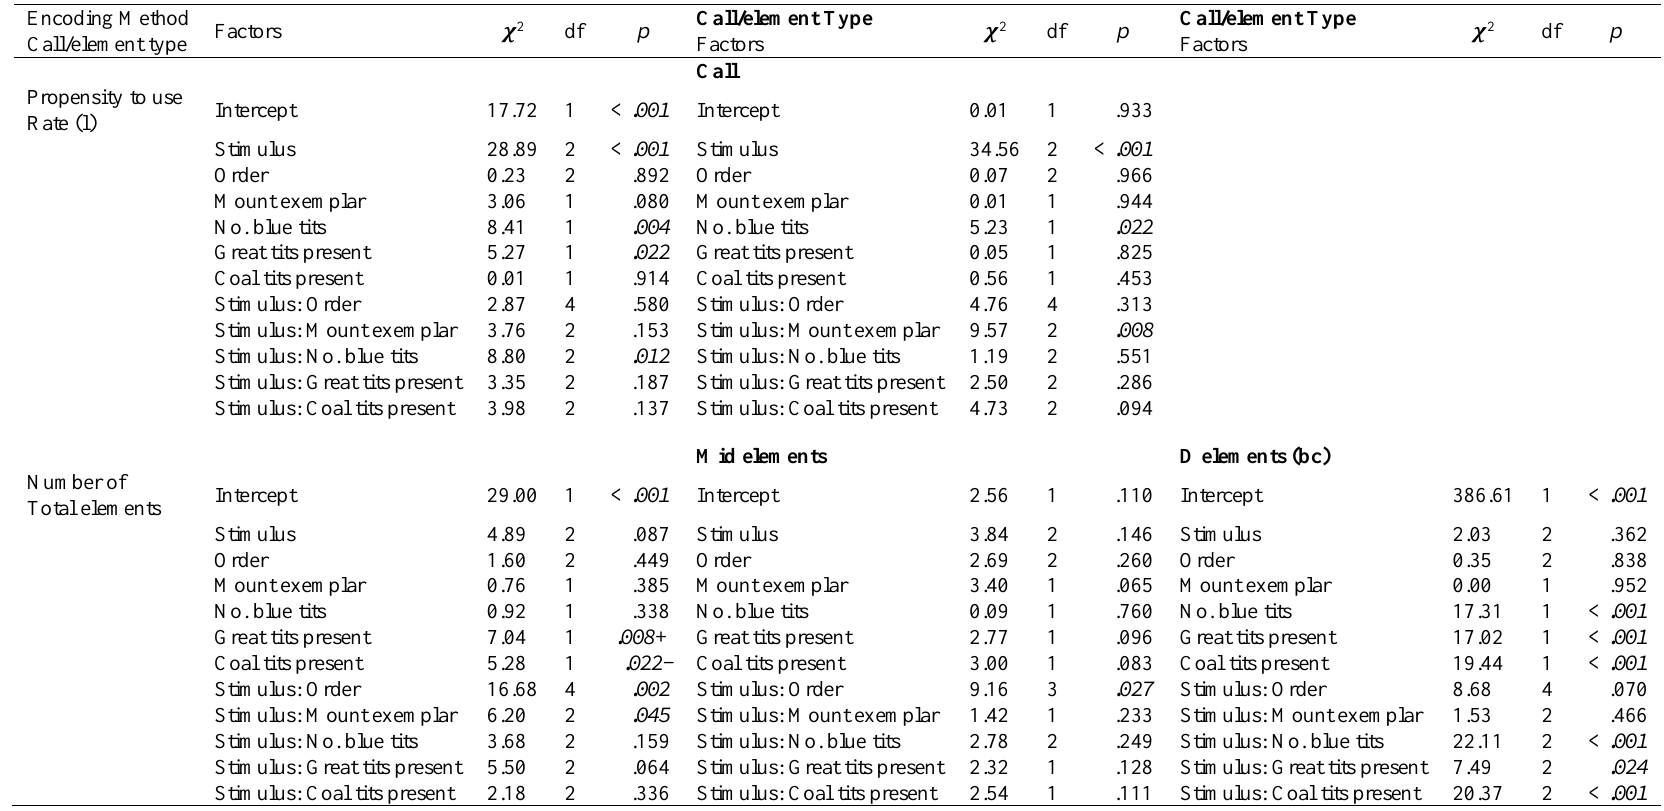
Test Results for Generalized and Linear Mixed Models Testing for Predator Type, Group Size (Conspecific and Flock Size) and Composition (Presence of Blue, Great, and Coal Tits) on Ways of Encoding Information about Predator Threat for Blue Tits § Indicates the Model Residuals were not Normally Distributed, L and Bc Indicate that Data was Log (L) or Box-Cox (Bc) Transformed if Residuals were not Normal for Linear Mixed Models. Bonferroni Corrected P-Values Based on the Number of Models are .005. In the Case of Significant Lower Order Effects Without Higher Order Interactions, + and – to the Right of the P-Value Indicate Whether the Effect is Positive or Negative,